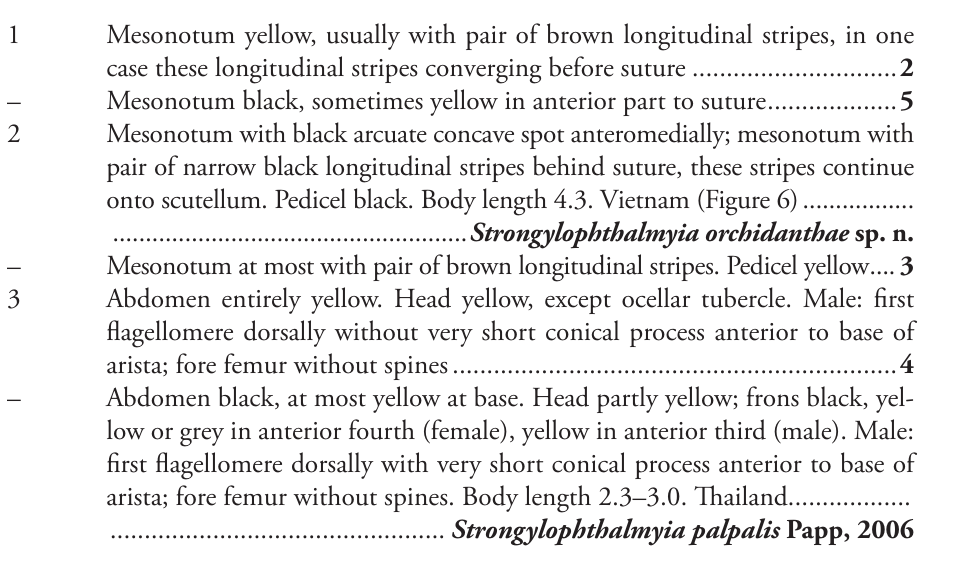
Mesonotum with black arcuate concave spot anteromedially; mesonotum with pair of narrow black longitudinal stripes behind suture, these stripes continue onto scutellum. Pedicel black. Body length 4.3. Vietnam (Figure 6) ................. Mesonotum at most with pair of brown longitudinal stripes. Pedicel yellow .... 3 Abdomen entirely yellow. Head yellow, except ocellar tubercle. Male: first flagellomere dorsally without very short conical process anterior to base of arista; fore femur without spines ................................................................. 4 Abdomen black, at most yellow at base. Head partly yellow; frons black, yel- low or grey in anterior fourth (female), yellow in anterior third (male). Male: first flagellomere dorsally with very short conical process anterior to base